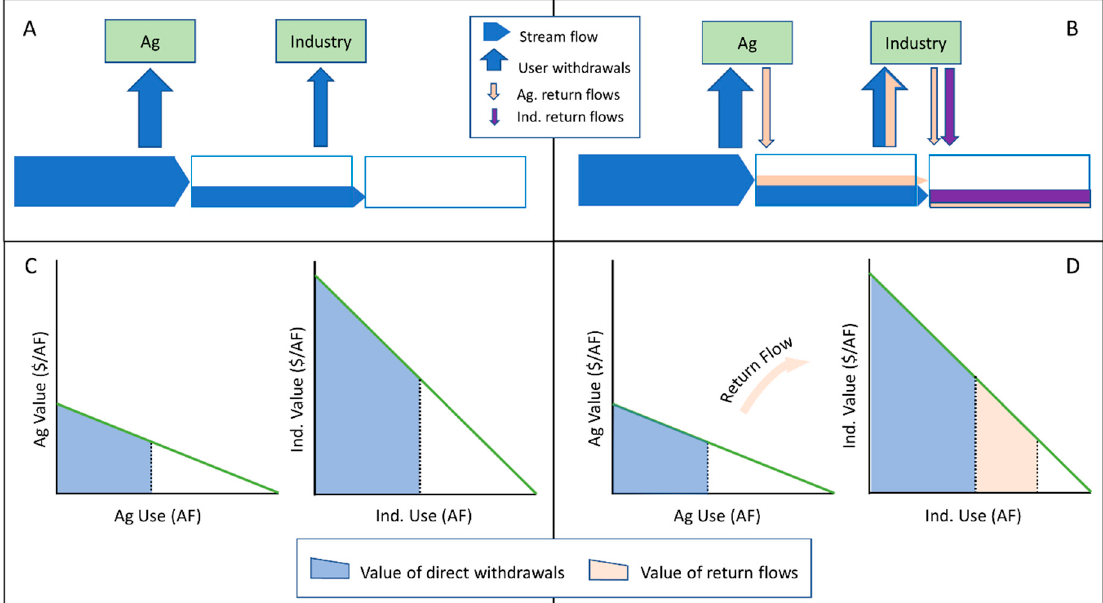
Figure 1. Schematic illustrating the relationships between water availability, water use, and economic output. ( A ) In a system with no return flows, stream depletion is a simple sum of all users’ water withdrawals. ( B ) When return flows are considered, stream depletion depends on both water withdrawals and return flows, generating additional water that can be allocated for additional use. ( C , D ) In our simple two-user system, total economic output is the sum of areas under the production curves for agriculture and industry. ( C ) Without consideration of return flows, output is limited and allocation is inefficient, as downstream user has a higher marginal value for water. ( D ) Additional output and improved economic efficiency are both possible considering return flows.